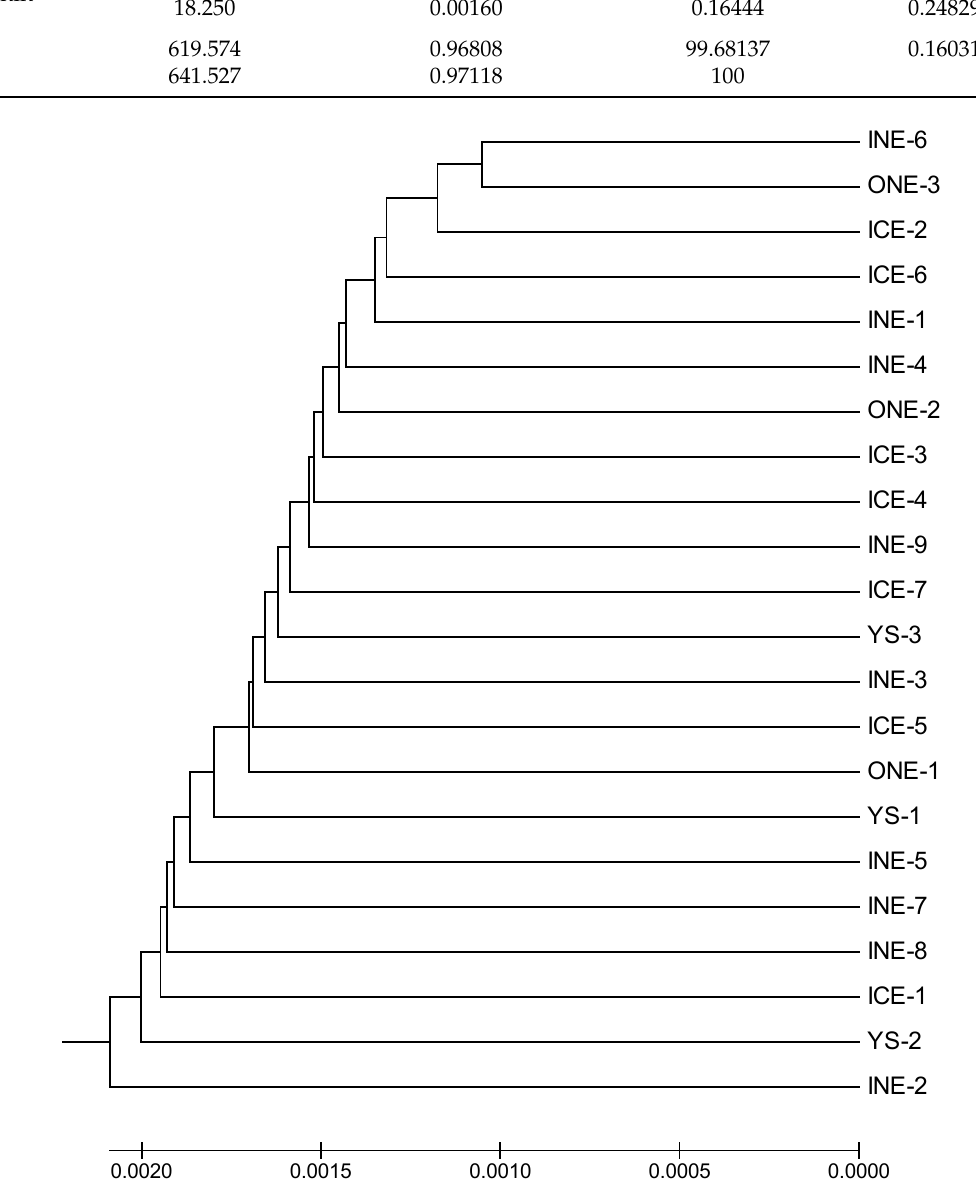
Figure 3. The UPGMA phylogenetic tree based on mtDNA COI sequences of the large yellow croaker. Note: YS: southern Yellow Sea; INE: inshore region of northern East China Sea; ONE: offshore region of northern East China Sea; ICE: inshore region of central East China Sea.